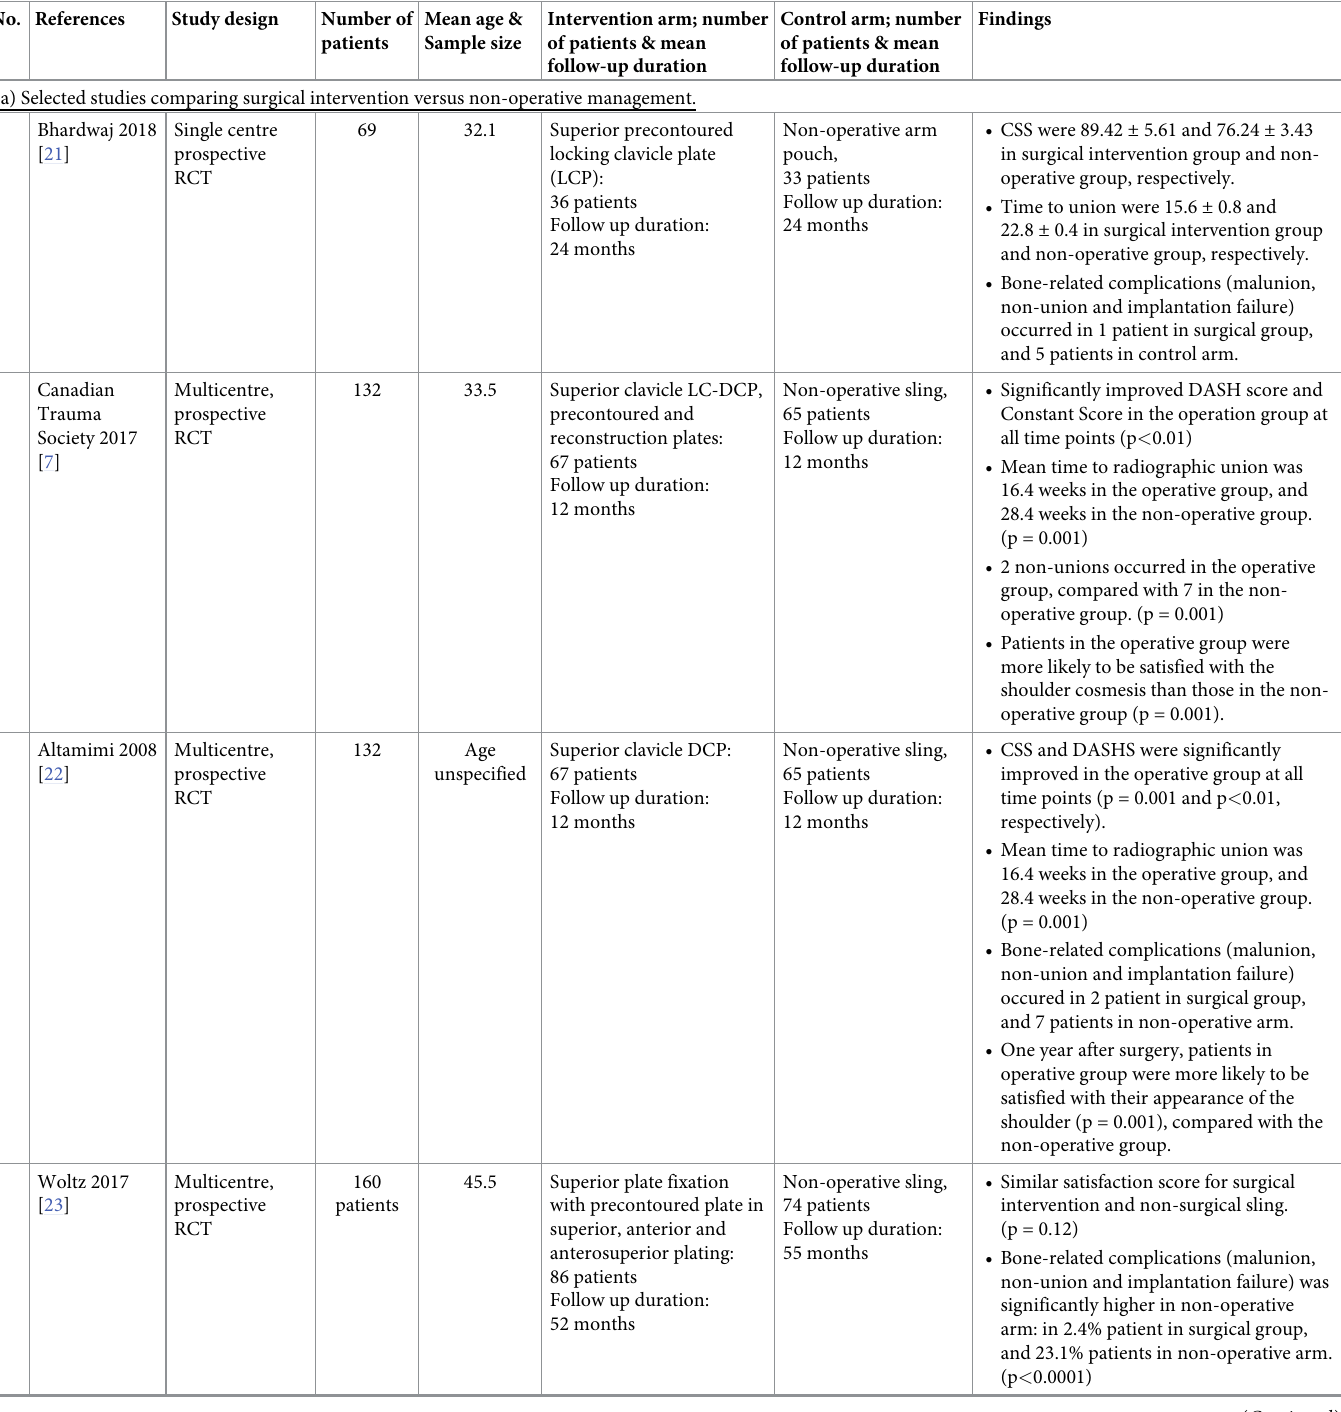
Table 1. Summary of the selected studies which fulfilled the inclusion criteria: 1) closed midshaft clavicular fractures; 2) aged 18 or above; 3) with informed consent and be able to comply with follow-up period; 4) medically fit for surgery and anaesthesia. Exclusion criteria were: 1) fracture at proximal or distal third of the